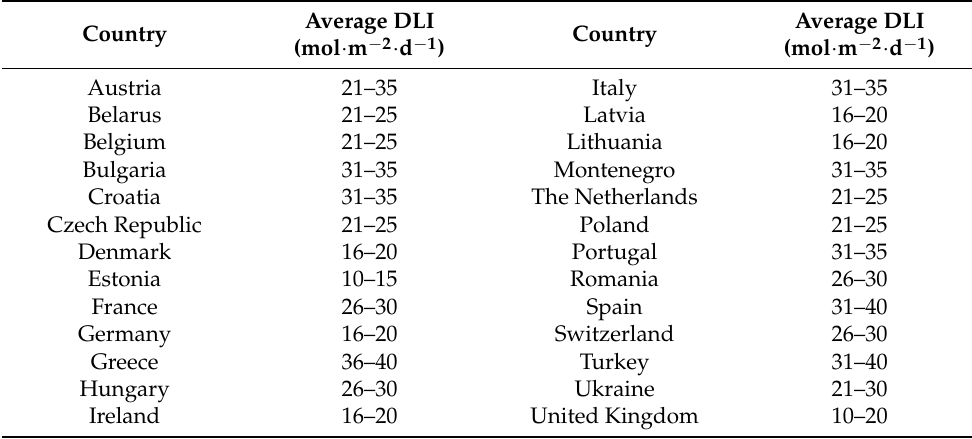
Table 7. Average annual daily light integral (DLI) in Europe